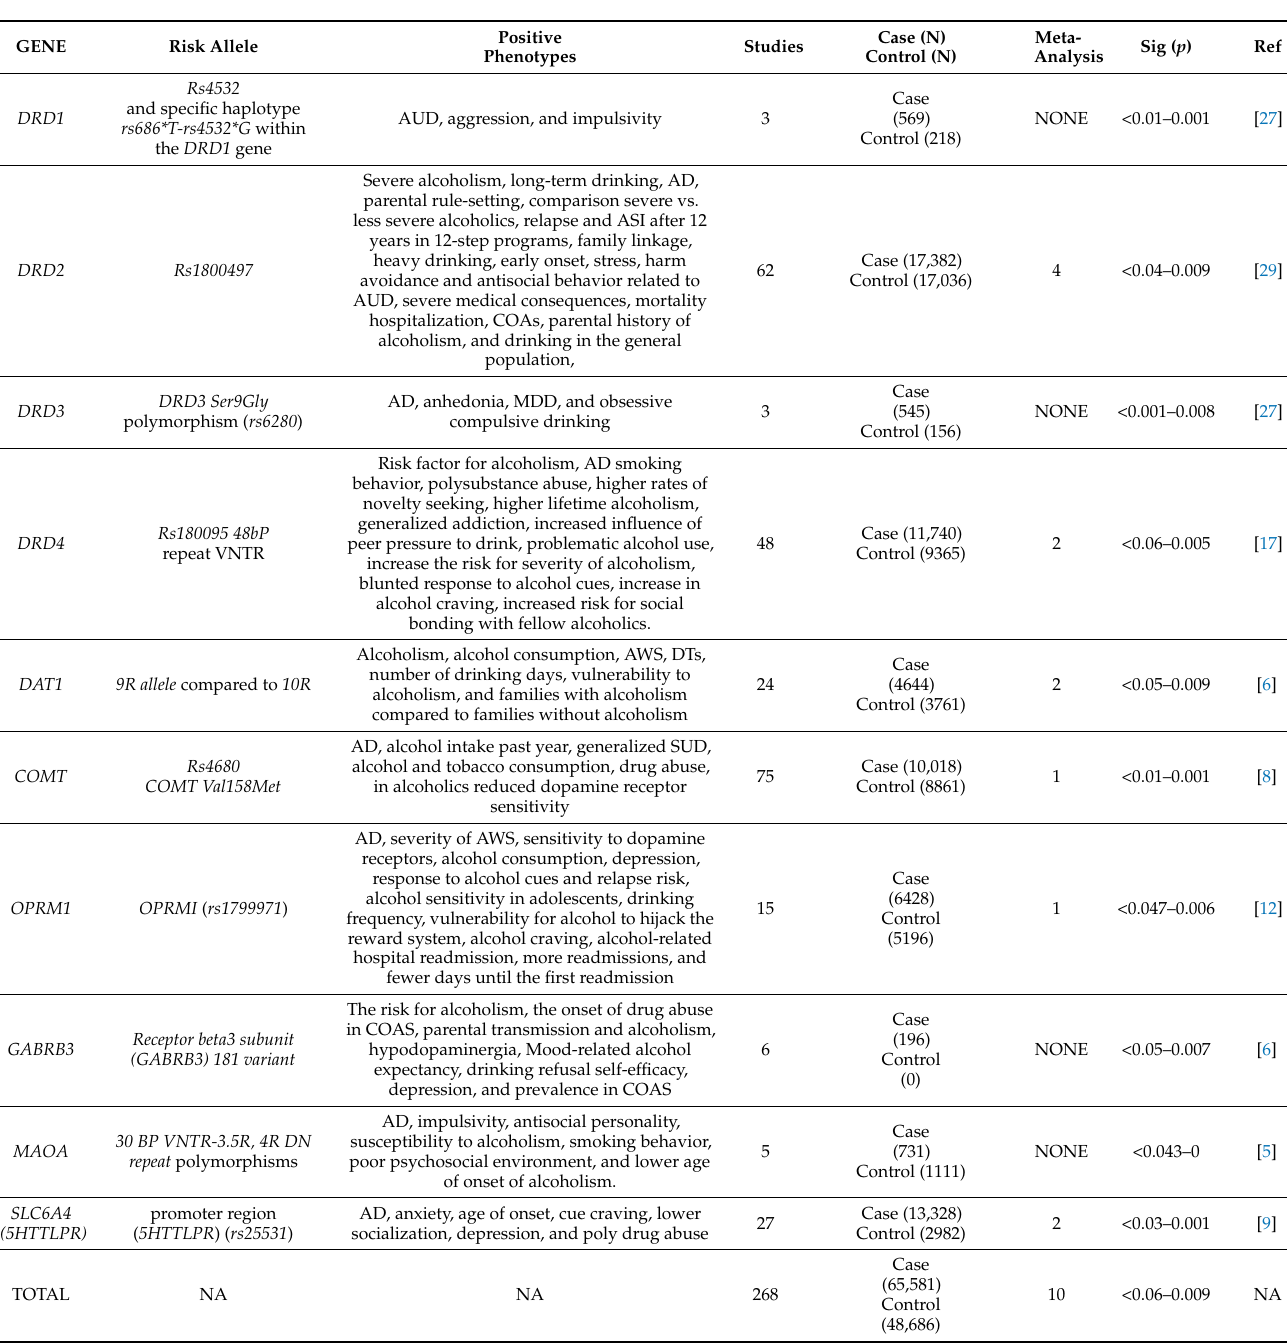
Table 1. Summary of studies used for controls *.